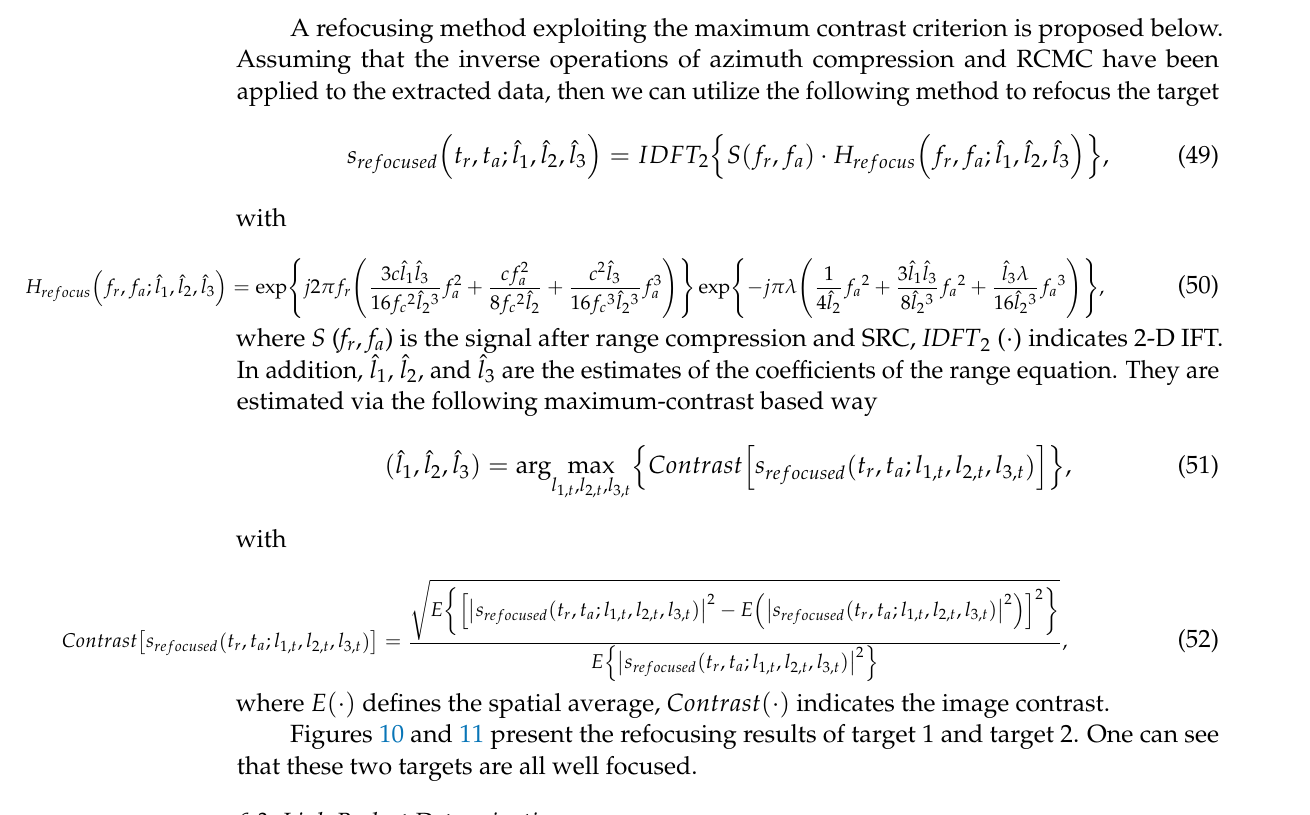
Figure 9. Flowchart of moving target detection and refocusing.